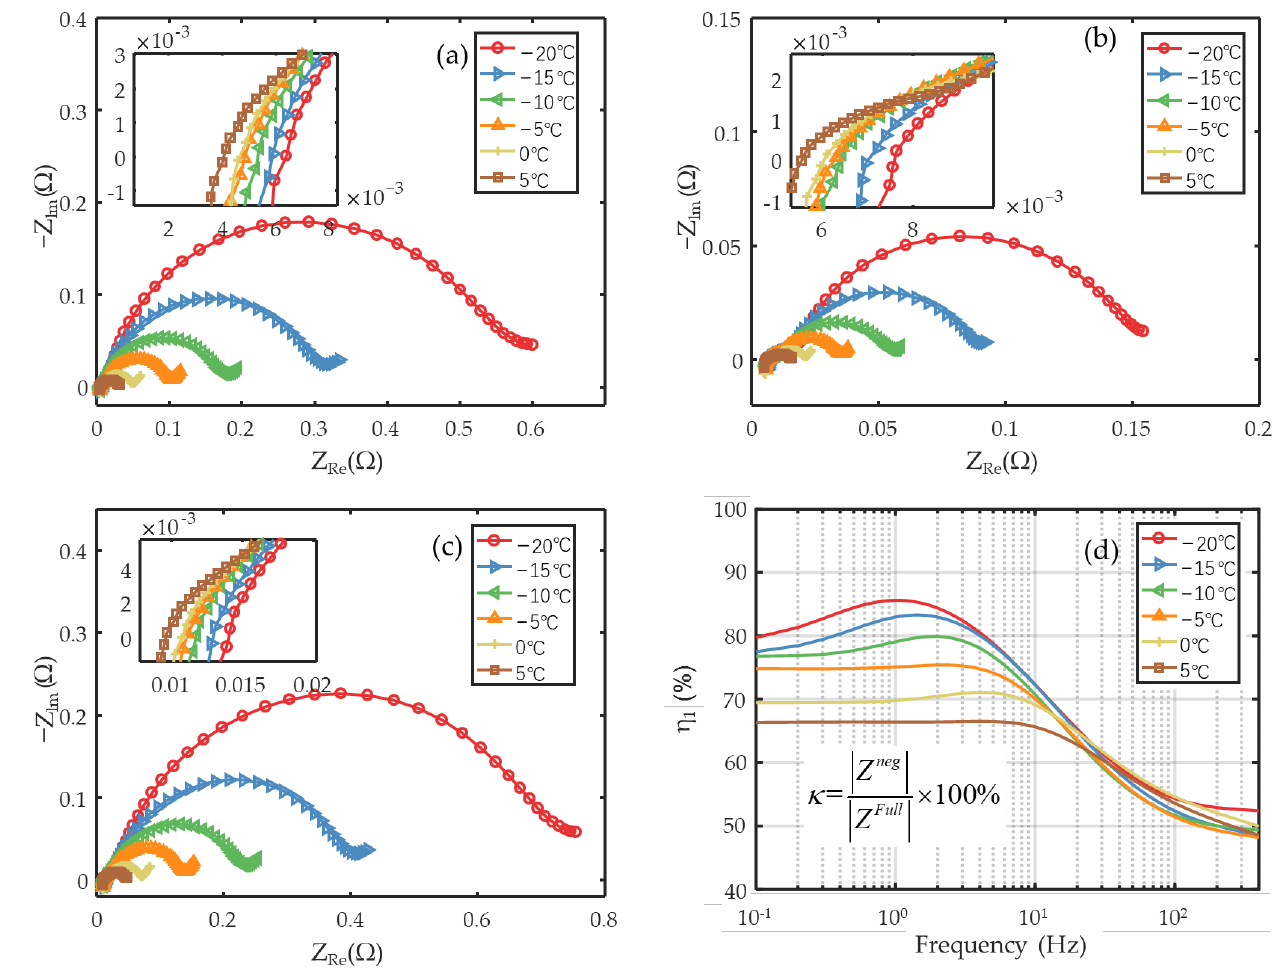
Figure 3. EIS results at different temperatures: ( a ) EIS of negative electrode; ( b ) EIS of positive electrode; ( c ) EIS results of full battery; ( d ) the proportion Κ of the negative electrode impedance to the full battery impedance.